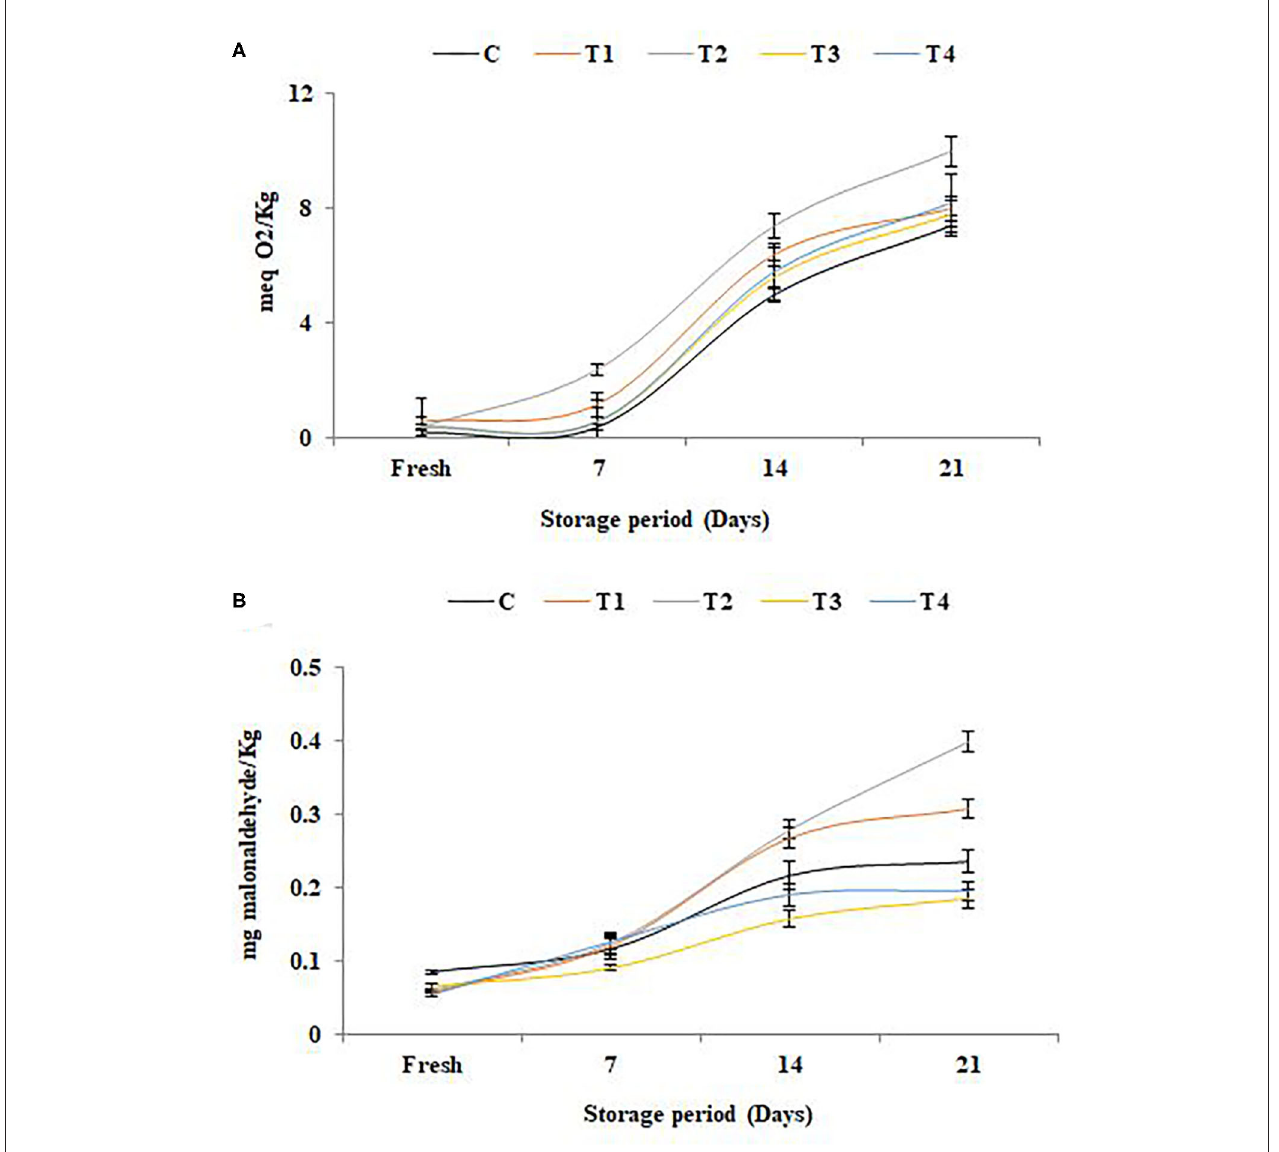
FIGURE 4 | Lipid oxidation in stirred functional yogurt during storage. (A) Thiobarbituric acid reactive substances (TBARS) value. (B) Peroxide value. Data represented are means of duplicates ± SD. C, Control plain SFY; T 1 , SFY fortified with free Fe + ascorbic acid; T 2 , SFY fortified with free Fe + FA + ascorbic acid; T 3 , SFY fortified with Fe@BSA-NPs + ascorbic acid; T 4 , SFY fortified with Fe + FA @BSA-NPs + ascorbic acid. BSA-NPs, Bovine Serum Albumin nanoparticles; FA, Folic Acid.